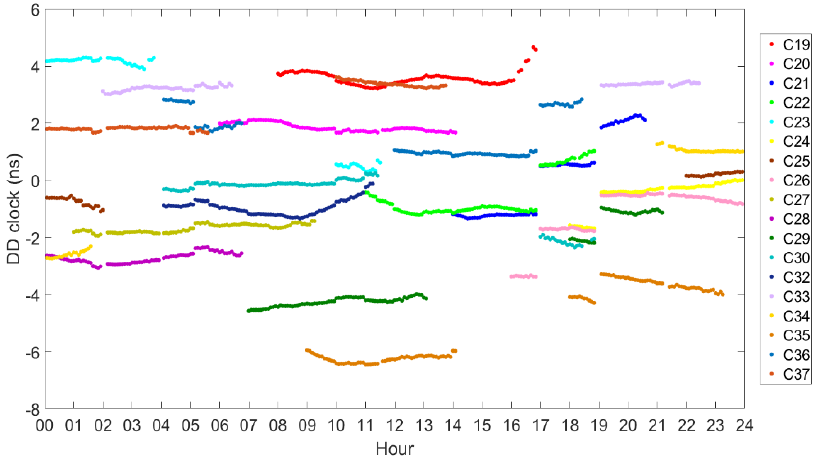
Figure 7. BDS-3 clock offset errors for the PPP-B2b products.